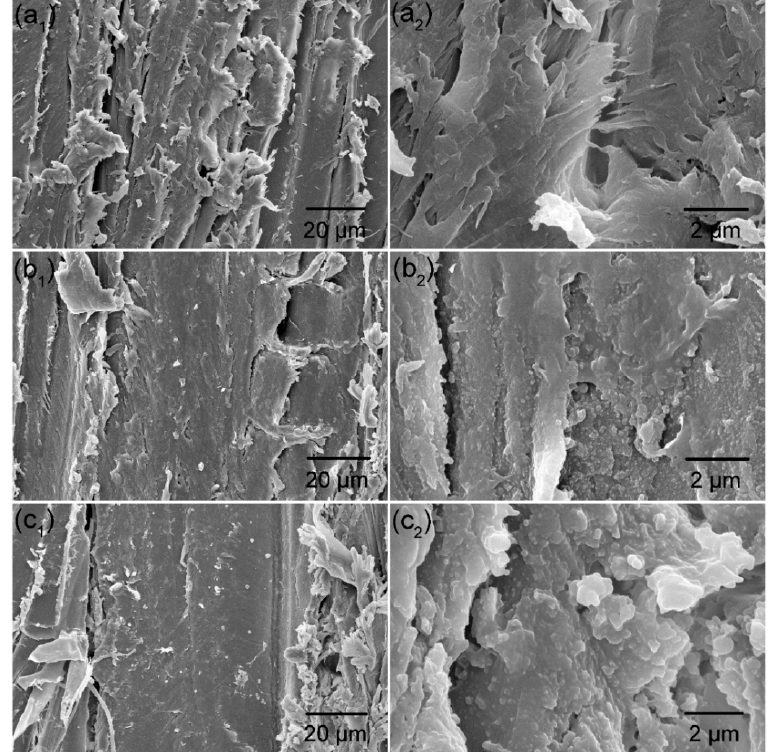
Figure 1. SEM observations of tangential sections of ( a ) control wood; ( b ) PDA/Wood; and ( c ) PDA/Cu/Wood at different magnifications.